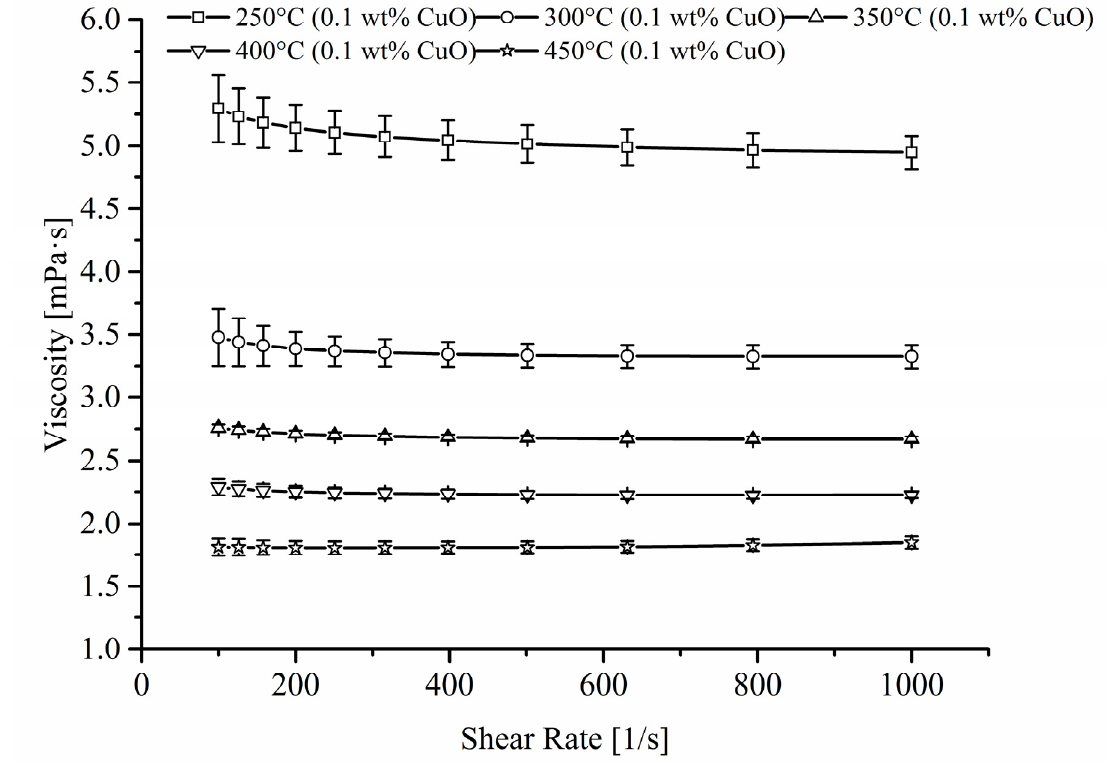
Figure 7. Effect of viscosity against rising shear rate when 0.1 wt % CuO nanoparticles is added to a binary eutectic mixture of sodium and potassium